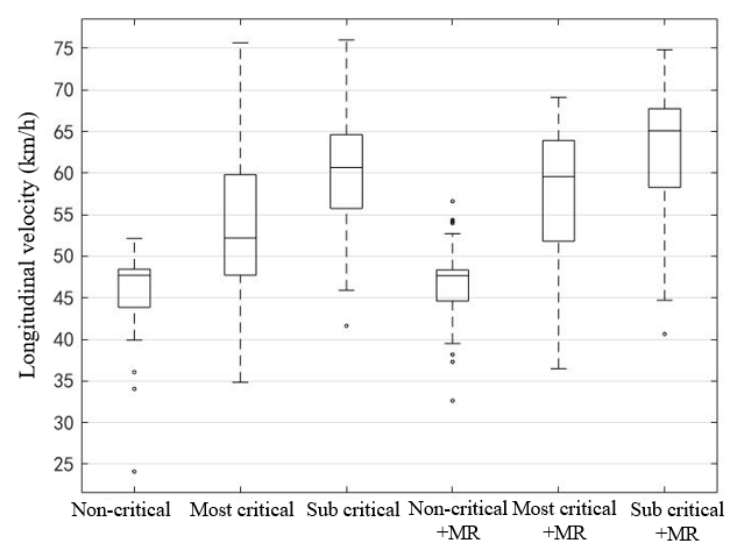
Figure 14. Box plots of mean longitudinal speed within 5 s after taking over.